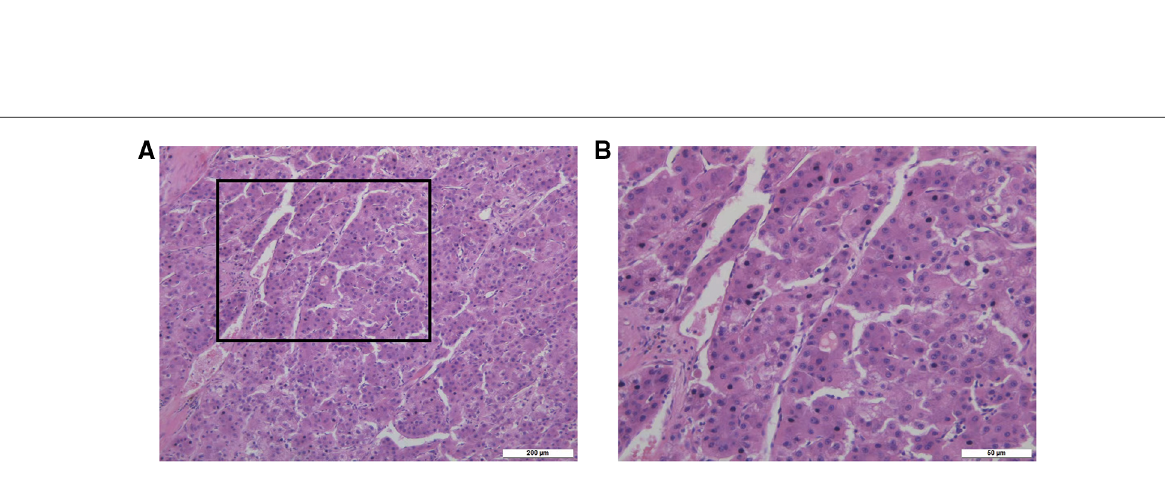
FIGURE 4 ( A ) the pathological picture of tumor in right seventh rib con fi rmed hepatocellular carcinoma metastasis under 10× microscope. ( B ) The pathological picture of tumor in right seventh rib con fi rmed hepatocellular carcinoma metastasis under 40×